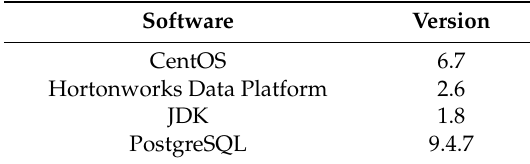
Table 3. Implementation and testing environment for Marmot.